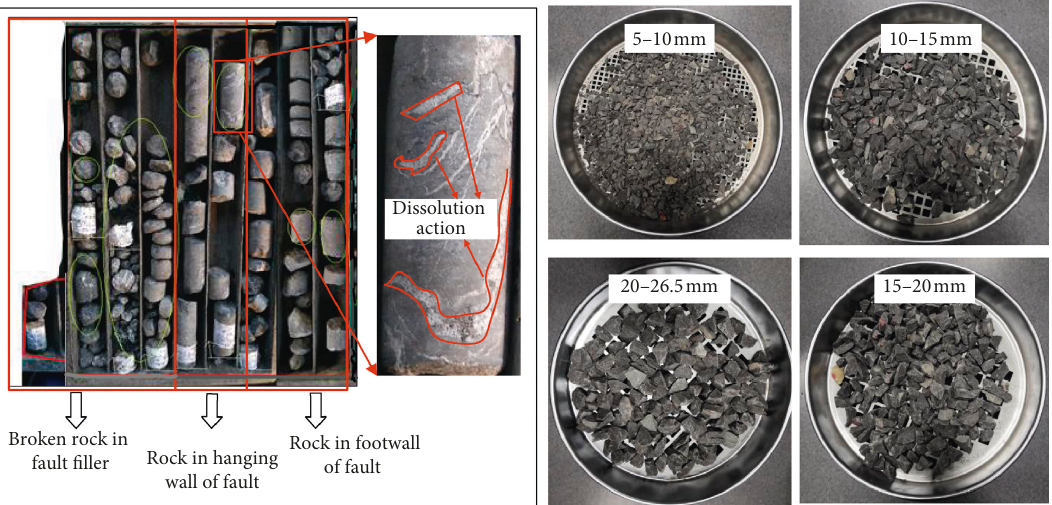
Figure 4: Sample preparation.